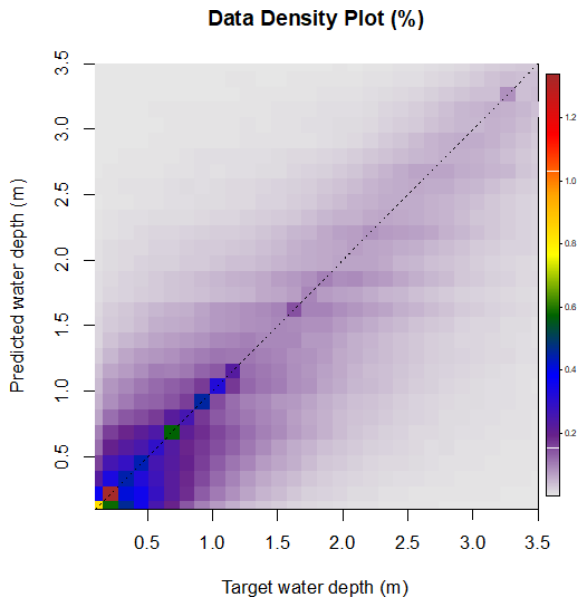
Figure 10. Data density plot (%) for target vs. predicted expected maximum water depth (target values: empirical JRC 100; predicted values: regressor DT applied to the test